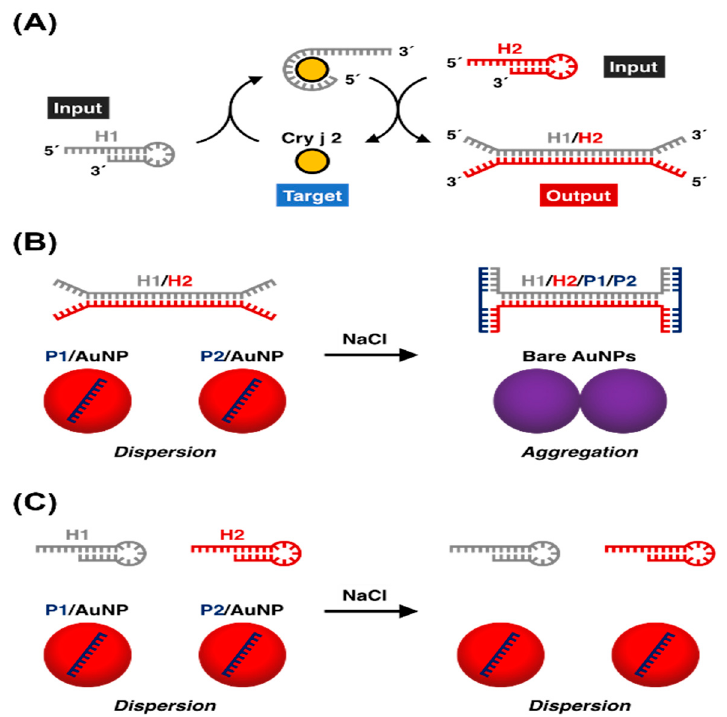
Figure 5. A non-crosslink aggregation assay showing the principle of catalytic target recycling. ( a ) The Cry j 2 target catalyzes the reaction of the hairpins H1 and H2 into a duplex structure, to produce an H1 / H2 duplex after each cycle. ( b ) In the presence of Cry j 2, the H1 / H2 duplex forms a three-way DNA junction with P1. Thus, the color does not change due to the colloidal stabilization of ssDNA–AuNPs. ( c ) In contrast, the red-to-purple color change is caused by salt-induced non-cross-linking aggregation of dsDNA − AuNPs in the absence of Cry j 2. Reproduced with permission from Reference [71]. American Chemical Society, 2019.